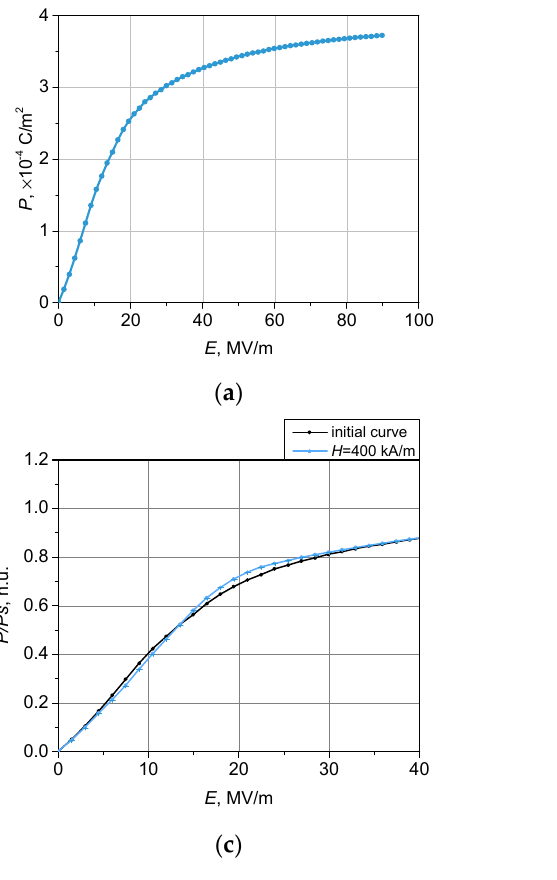
Figure 3. Simulated polarization ( a ) and magnetization ( b ) curves for a soft elastic matrix filled with a mixture of FM and FE particles. ( c ) Polarization curves under an external (bias) magnetic field: H = 0 and 400 kA/m; ( d ) magnetization curves under an external (bias) electric field: E = 0 and 90 MV/m.